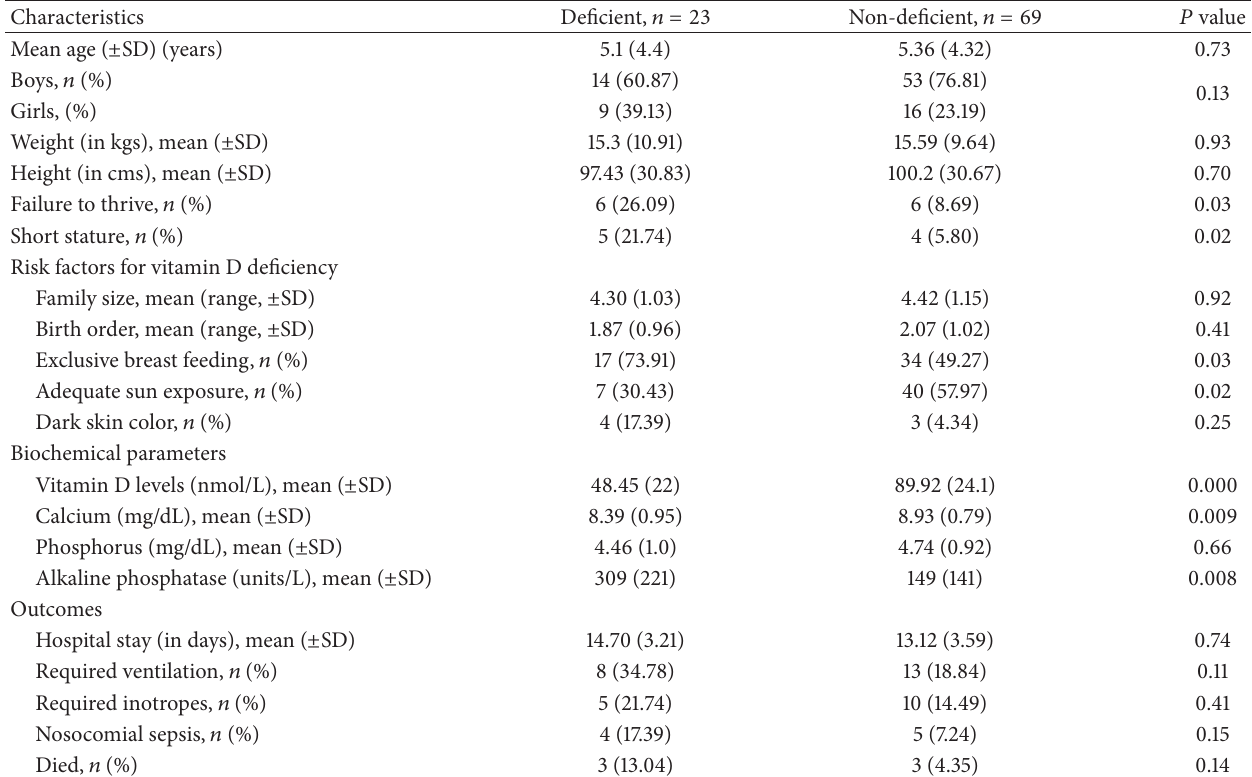
Table 5: Comparison of various variables between vitamin D deficient and nondeficient children at timepoint 1.